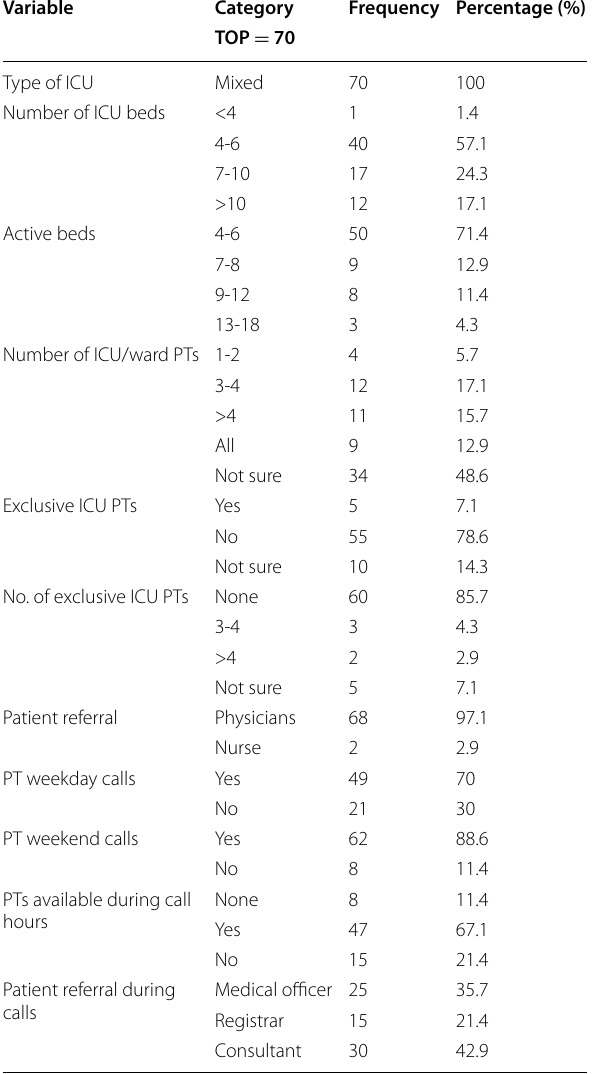
Table 2 ICU demographical